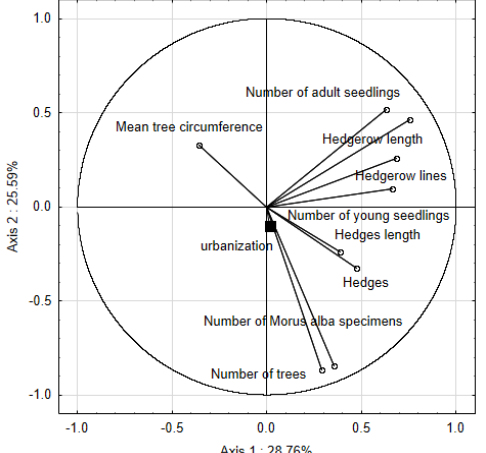
Figure 5. Principal component analysis conducted for parameters characterizing natural and artificial renewal of Morus alba . The level of urbanization was introduced into analyses as an additional variable.